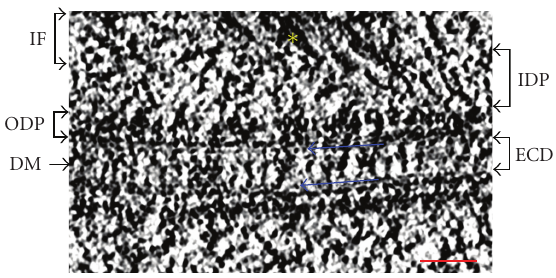
Figure 1: A tomographic slice of a desmosome bridging two opposing keratinocytes (delineated by two blue arrows) from the epidermis of a newborn mouse. Intermediate filaments (labeled IF and marked by a yellow asterix) from neighboring cells are inter- connected to each other via the transmembrane cadherin proteins. Intracellular bridging proteins of the inner dense plaque (labeled IDP is a structural framework that includes cadherin intracellular domains, plakoglobin, plakophillin, and the N-terminal domain of desmoplakin) and the outer dense plaque (labeled ODP is a structural framework consisting of the rod domain and C-terminal domain of desmoplakin) link the intermediate filaments to the extracellular core domain (ECD). The ECD is composed of extra- cellular domains of desmosomal cadherins, namely, desmocollins and desmogleins. The area of cadherin interaction appears as a dense mid-line bisecting the ECD due to heterophilic associations between desmocollins and desmogleins. Scale bar represents 50